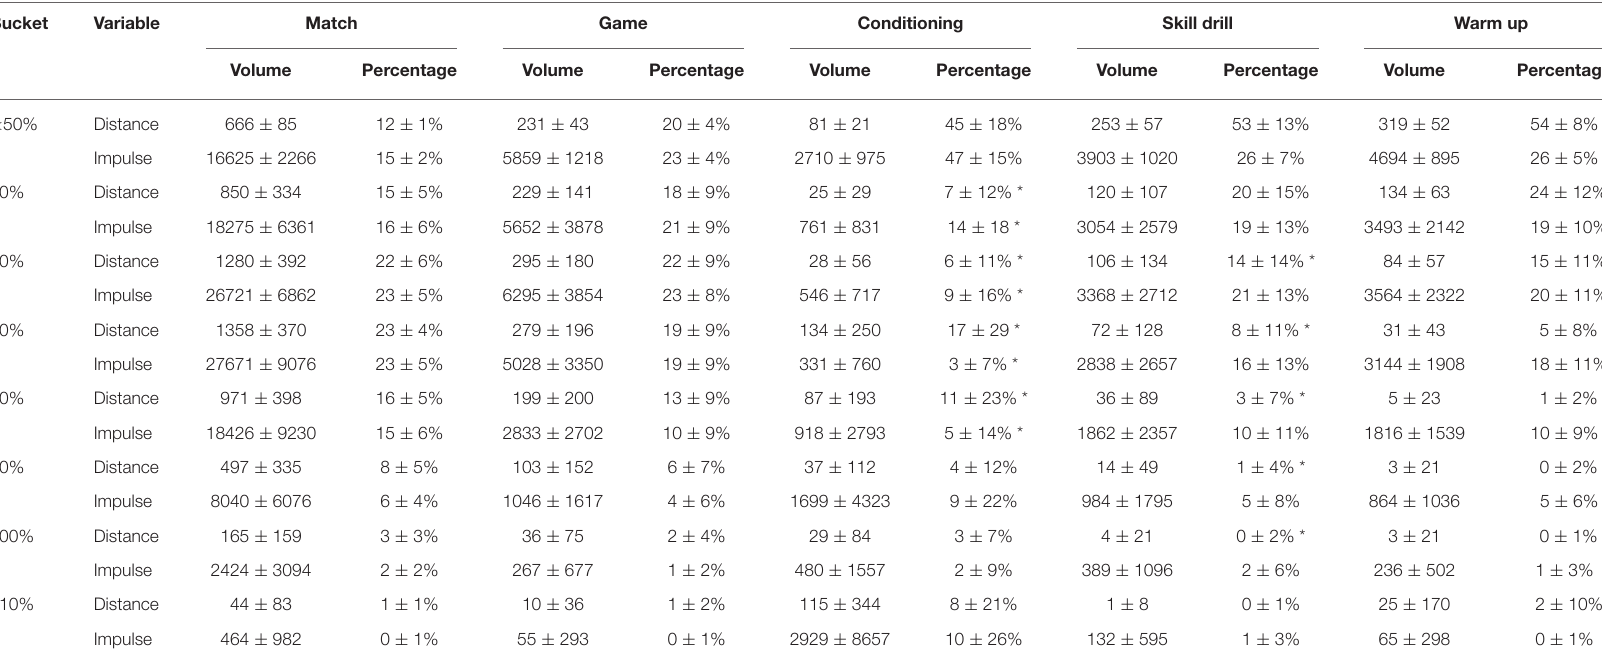
TABLE 2 | Descriptive data (mean ± standard deviation) of the volume and percentage of distance and impulse accumulated within each intensity bucket for each drill